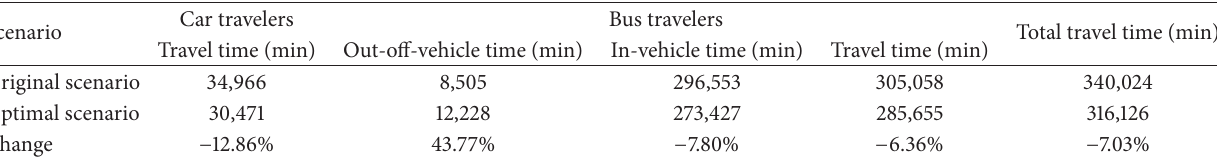
Table 6: The comparison between all-stop and skip-stop